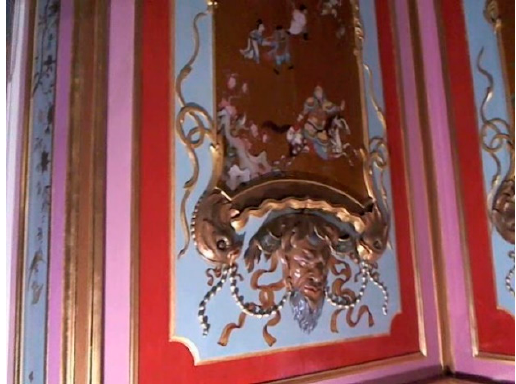
Figure 2. Sample frame taken using a Logitech B910 camera.